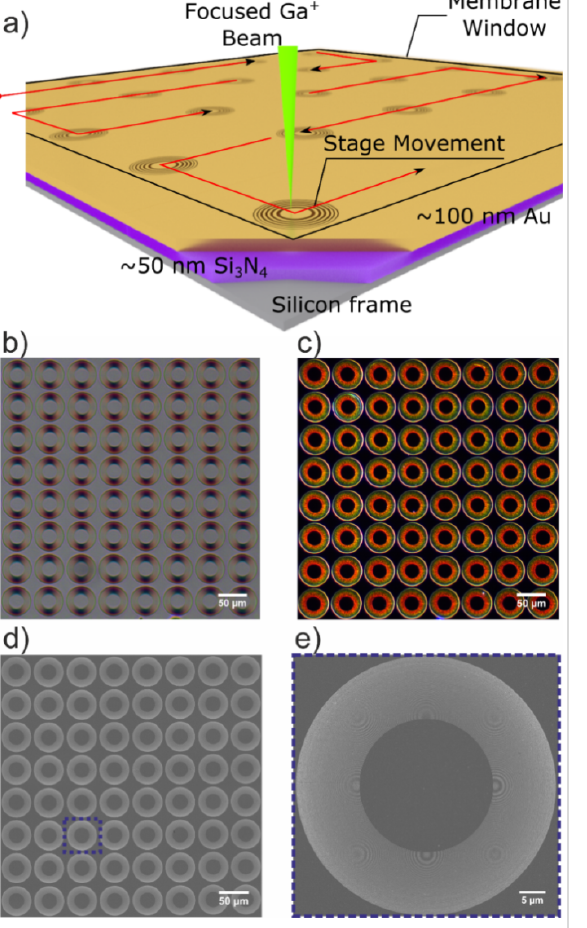
rameters takes less than 10 h including the stage travel and calculation